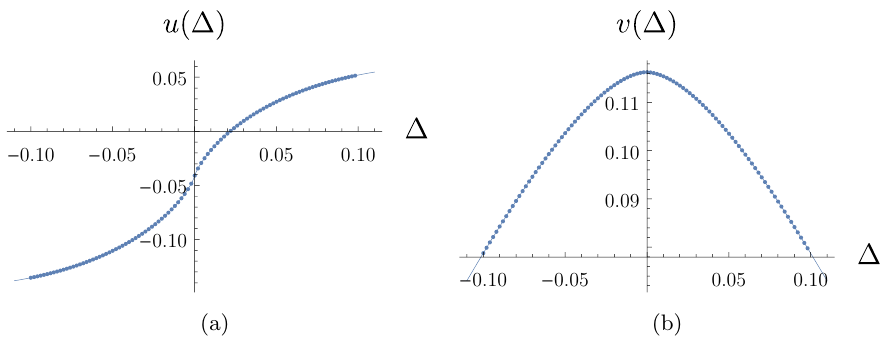
Figure 6 . u ((cid:1)) and v ((cid:1)) computed by the method of appendix A in the vicinity of (cid:1) = 0 and (cid:1) = 1. The solid lines correspond to the numerical (cid:12)ts (5.12),